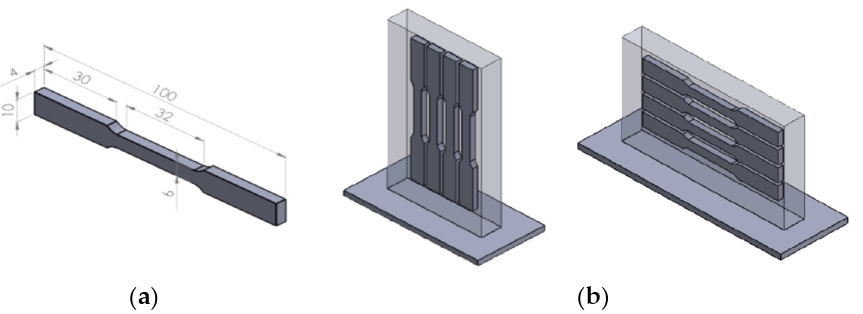
Figure 3. ( a ) Dimensions of tensile specimens in mm and ( b ) schematic representation of the vertical and horizontal specimens in the part.